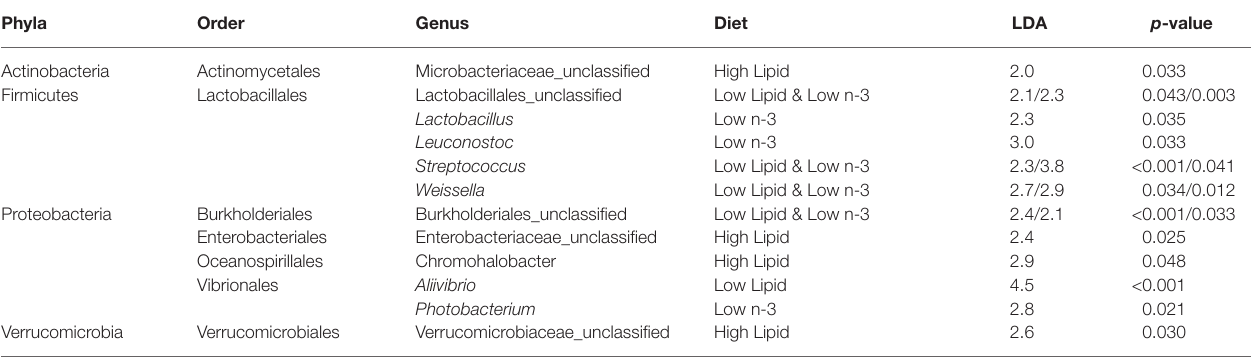
LDA; linear discriminant